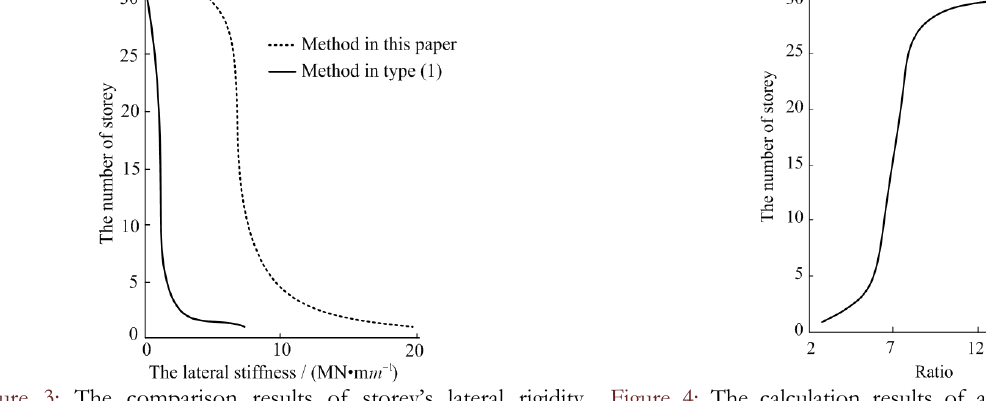
Figure 3: The comparison results of storey’s lateral rigidity calculated with two methods.